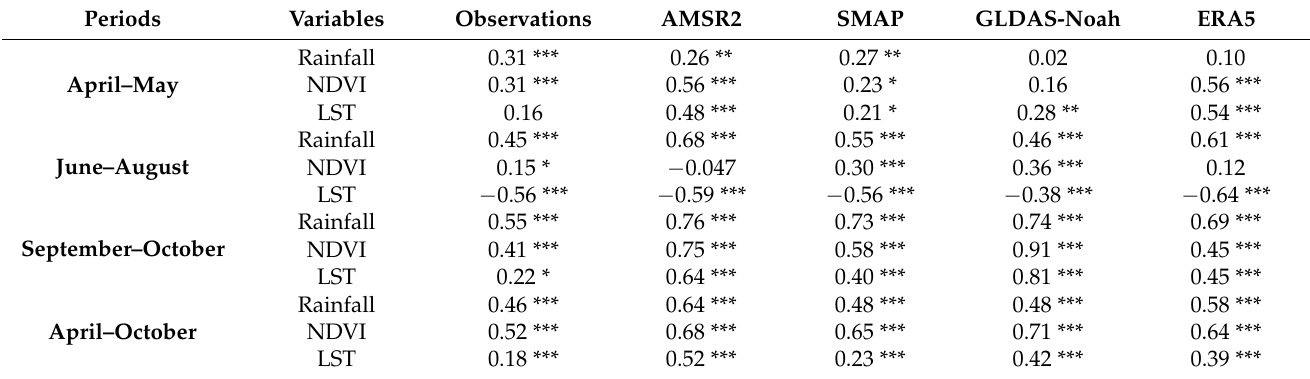
Table 4. The ρ between SM (in situ observation, AMSR2, SMAP, GLDAS-Noah, and ERA5) and influencing factors (rainfall, NDVI, and LST) in different seasons from 2015 to 2016 in the TP. *, **, and *** represent the statistically significant at 95%, 99%, and 99.9% confidence levels, respectively. Observations AMSR2 SMAP GLDAS-Noah